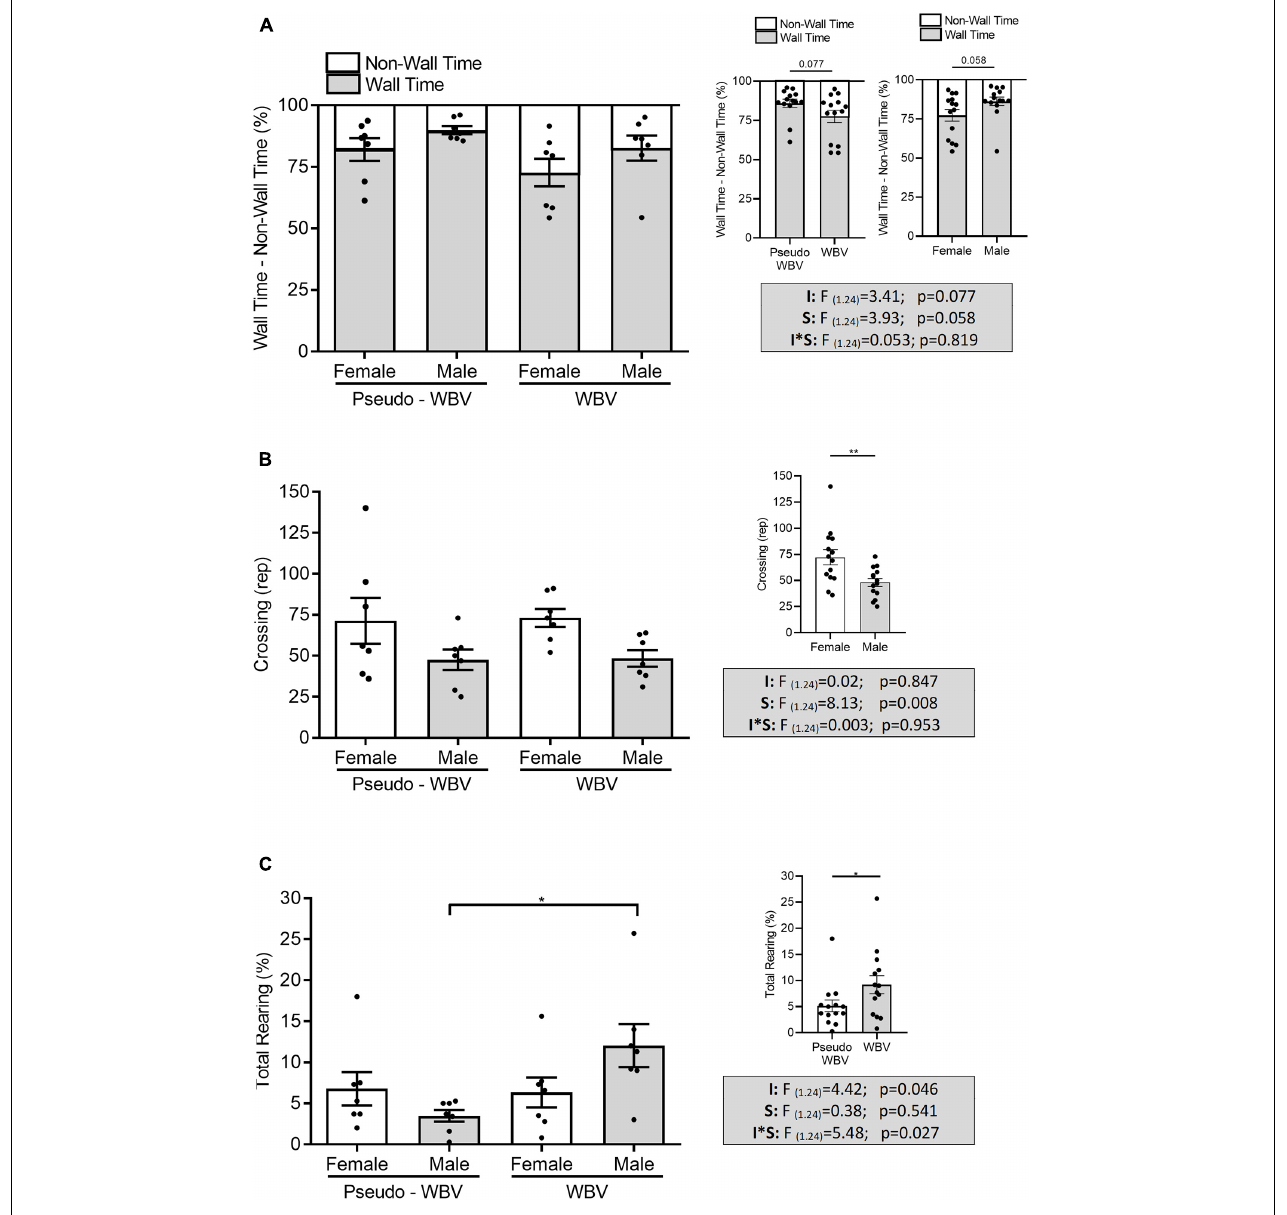
FIGURE 3 | The effects of whole body vibration on exploratory and anxiety-related behavior in the open field test in aged male and female rats. Data are presented as percentage of wall vs. non-wall time (i.e., they are reciprocal of each other). All animals spent more than 50% of the total time in the wall zone. Vibration-treated animals showed a strong tendency ( p = 0.077) of decreased time spent in the wall zone and increased time spent in the center zone (A) . The number of crossings significantly increased in the female animals (B) . Time spent with rearing increased significantly in the vibration-treated male group compared with the pseudo-treated male group (C) . Two-way ANOVA was used for analyzing these results. Pseudo-whole body vibration ( n = 14, 7 females and 7 males); whole body vibration ( n = 14, 7 females and 7 males). F, F statistical value; I, main effect of intervention (vibration/pseudo vibration); S, main effect of sex (male/female); I*S, interaction effect of intervention and sex. Data are depicted as mean ± SEM. * p < 0.05 and ** p <